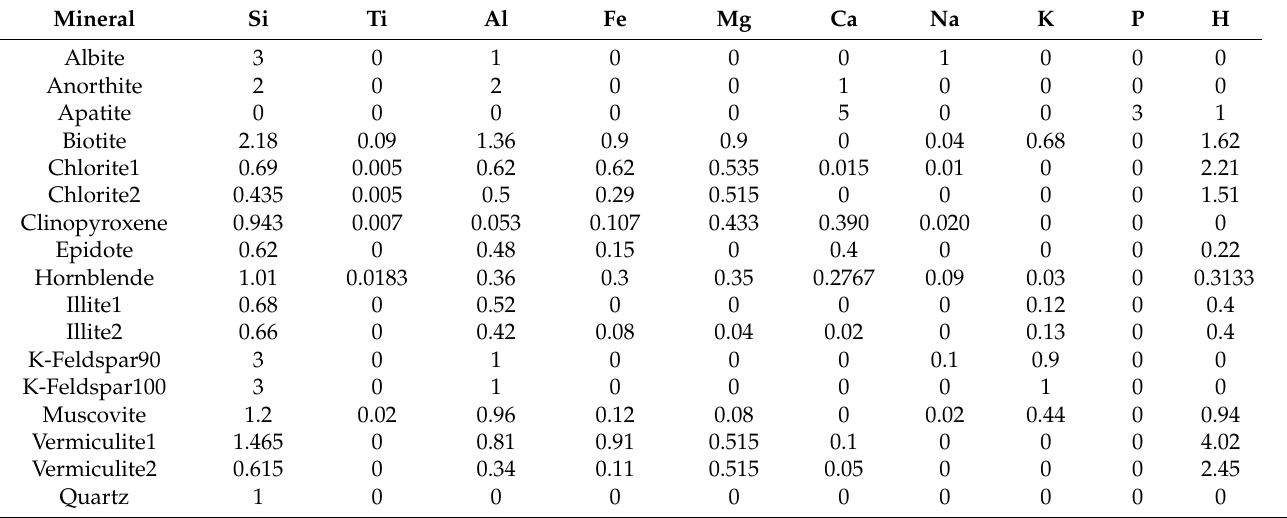
Table A6. Stoichiometry used for the normative